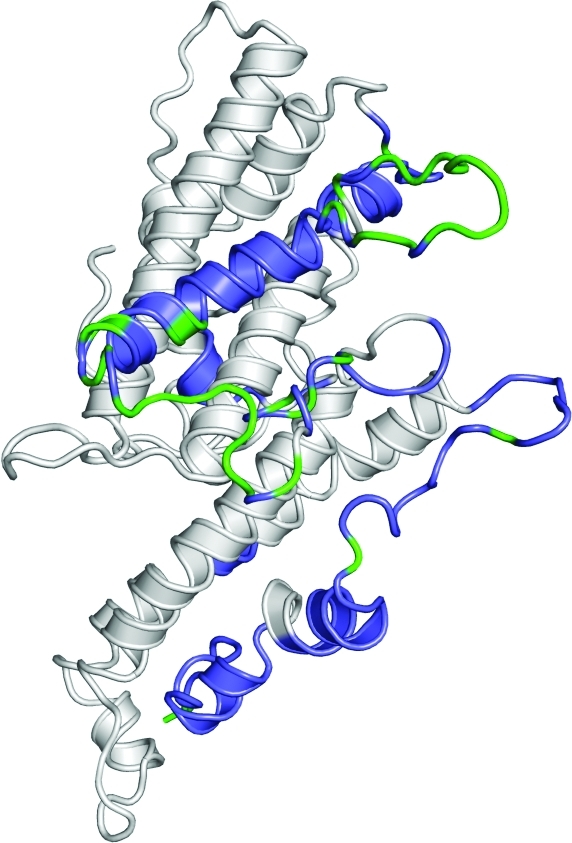
VAR2CSA DBL4 Regions Predicted to be Targeted by Surface-Reactive AntibodiesThe plot is similar to Figure 4, except viewed from the reverse side.